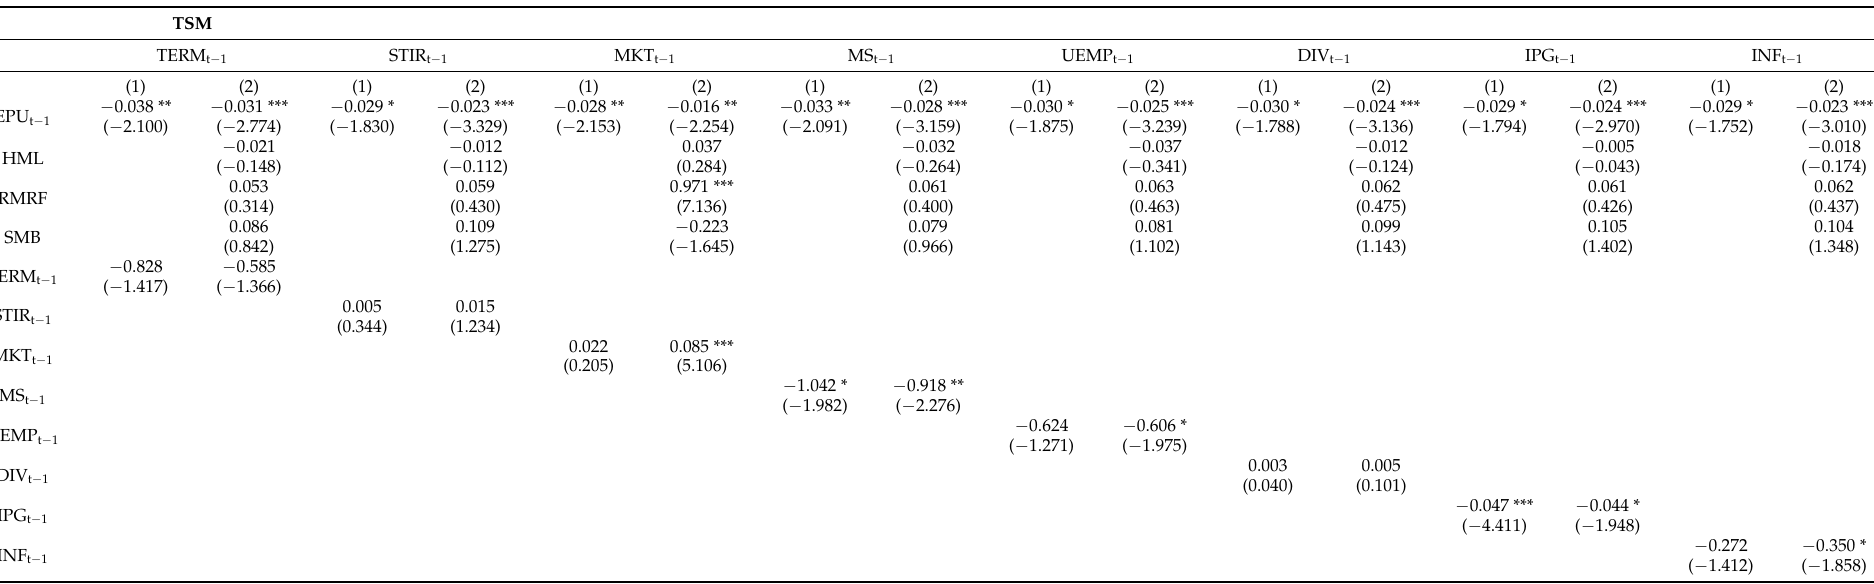
Table 11. Effect of EPU level on time series momentum strategy return in the Chinese stock market, controlling each of the macroeconomic factors. ***